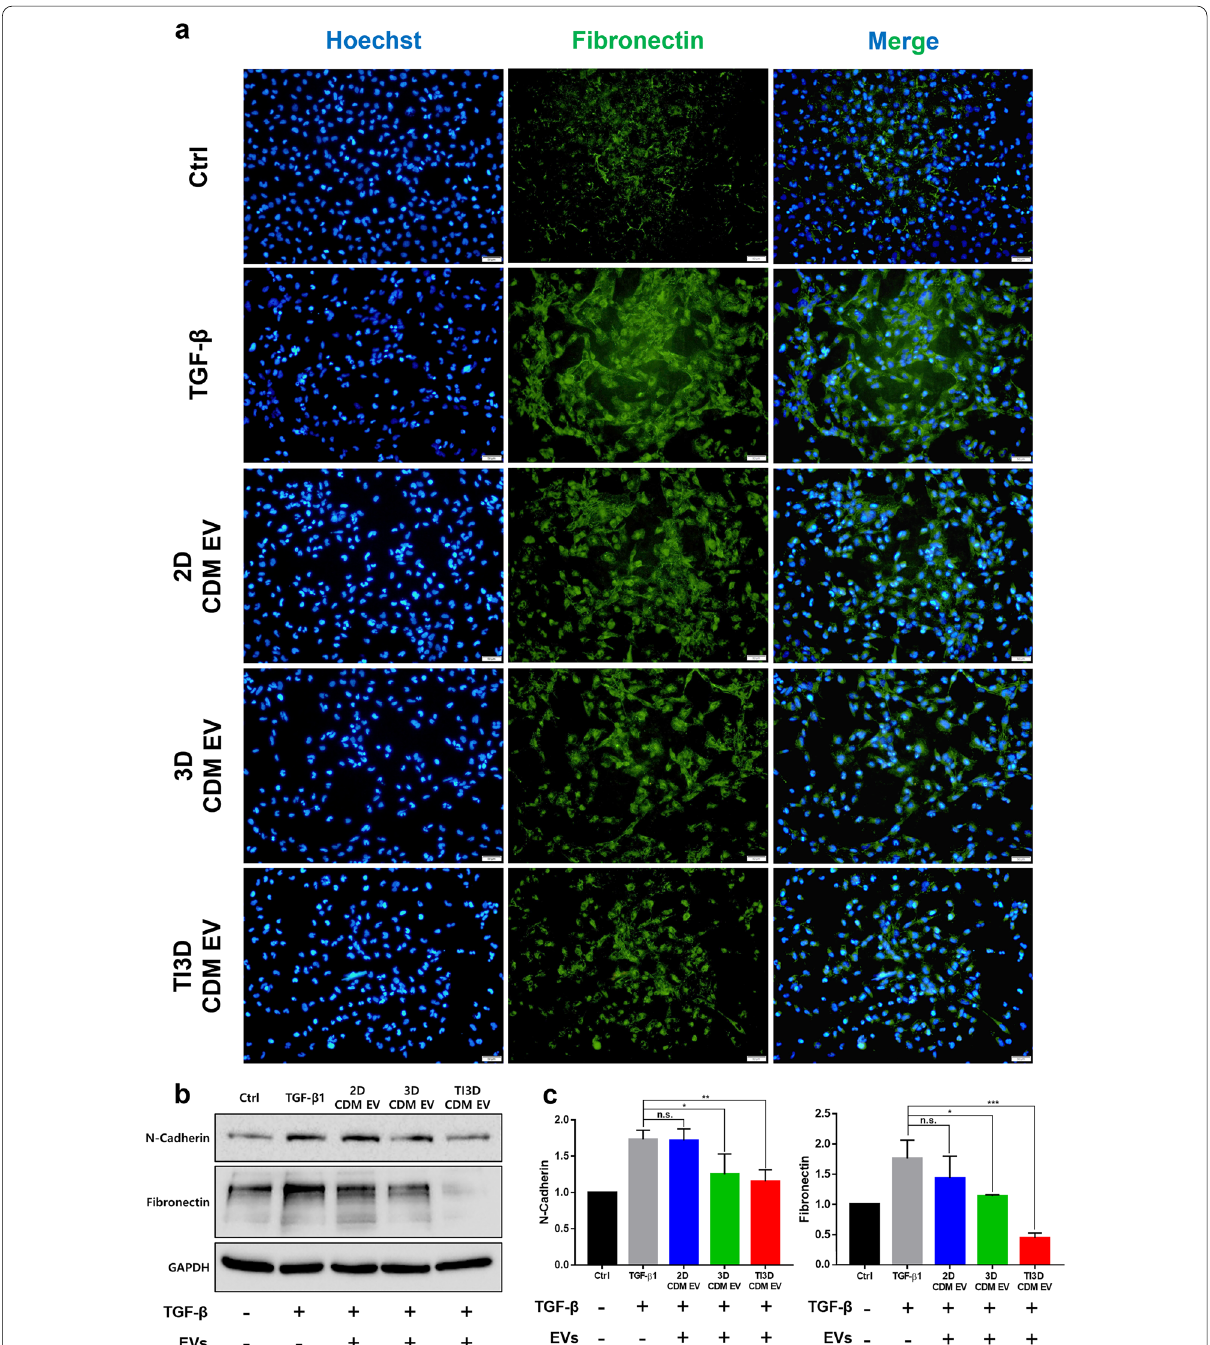
Fig. 8 Anti‑fibrotic properties of EVs. a The fluorescence‑based immunocytochemistry of fibronectin expression of TGF‑β induced fibrosis condition in HK2 cells. b Western blot analysis for representative fibrosis markers after EVs treatments in fibrosis induced‑HK2 cells. c Quantification data for N‑cadherin and fibronectin expression from Western blot analysis (analysis with Image J, values are presented as mean statistical significance was obtained with one‑way analysis of ANOVA with Tukey’s multiple comparison post‑test (* p < 0.05; ** p < 0.01; *** p < 0.001; **** p <